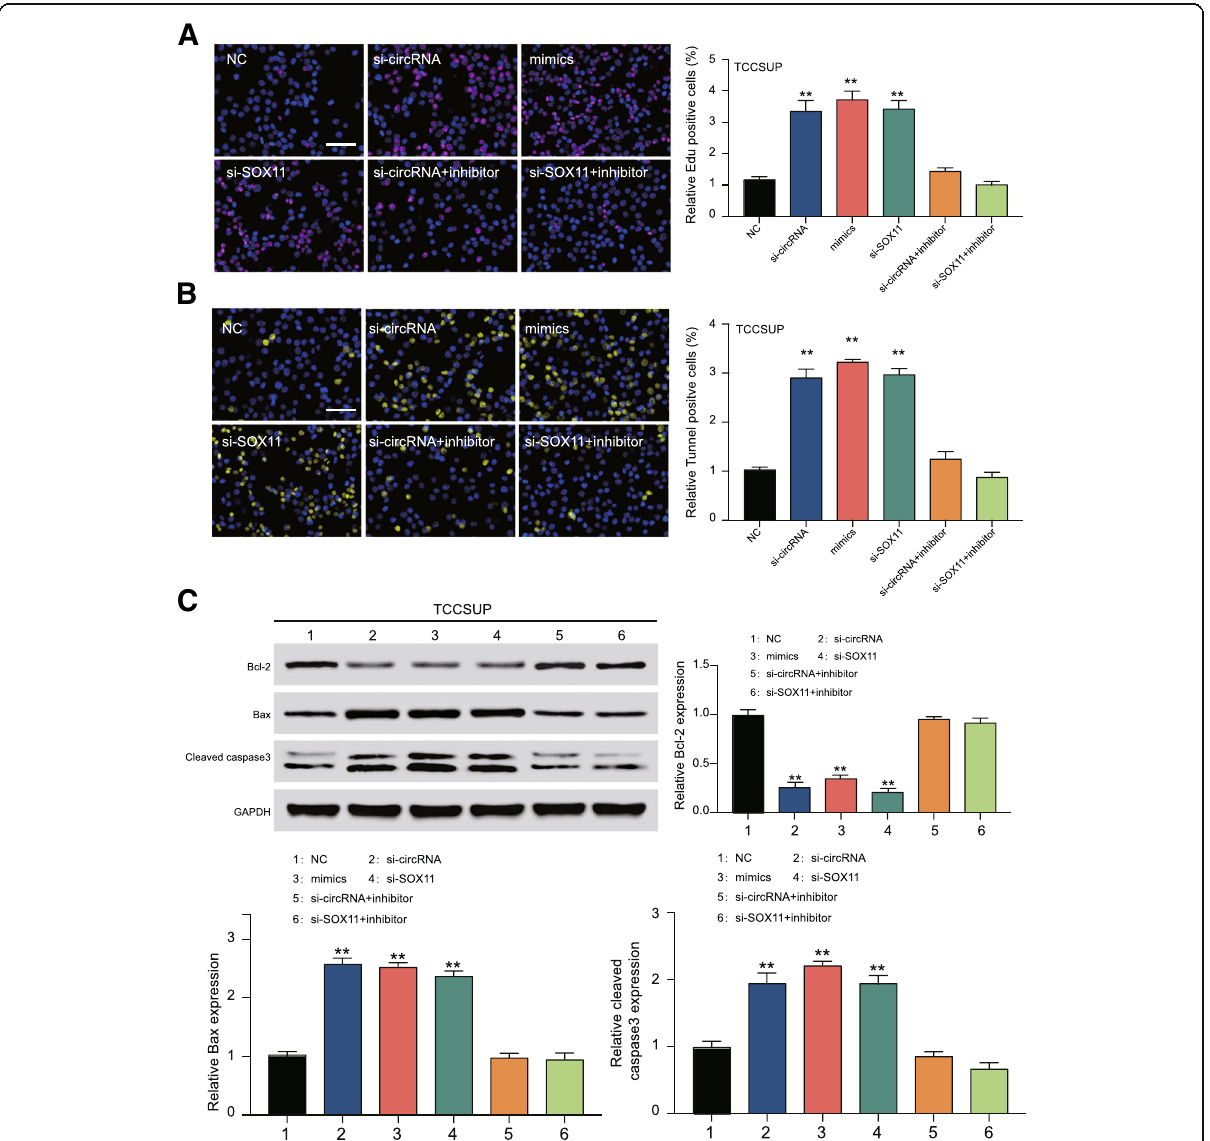
Fig. 8 Effects of circCEP128 on TCCSUP cell damage and apoptosis. After transfected with corresponding siRNA or mimics/inhibitor, higher DNA damage happened in si-circRNA, miR-145-5p mimics and si- SOX11 with the experiments of a Edu staining b Tunnel staining. ** P < 0.01, compared with NC. Scale bar, 20 μ m. c Western blot showed the result of apoptosis related proteins bax and caspase3 were higher but bcl-2 was lower in si-circRNA, miR-145-5p mimics and si- SOX11 groups compared with NC group. ** P < 0.01, compared with